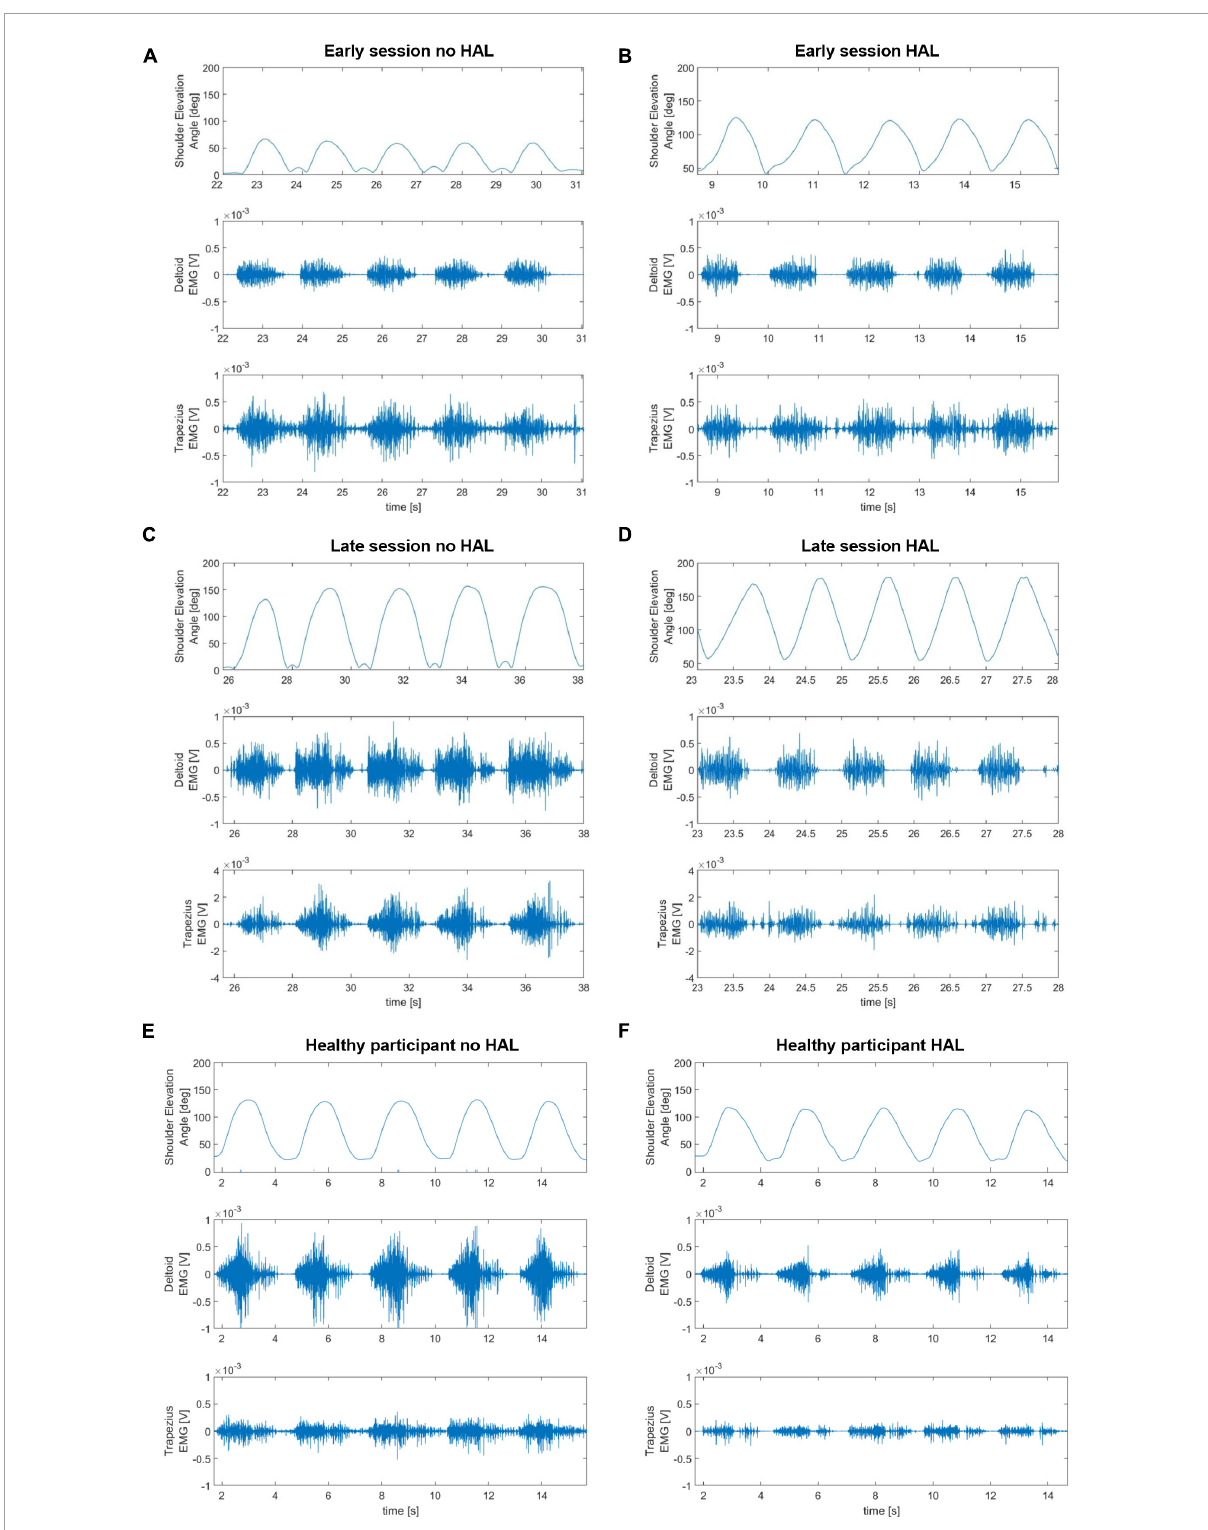
FIGURE4 Shoulder elevation angles and surface EMG of deltoid and trapezius without and with the HAL for an early session, on the top (A,B) ; a late session, in the middle (C,D) and a healthy participant, on the bottom (E,F)